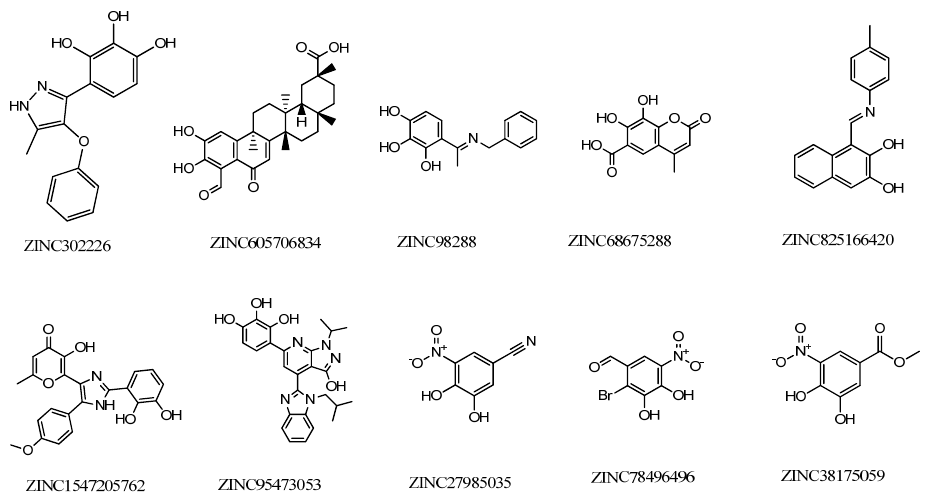
Figure 13. Structure and identification of the studied compounds. Table 3. Estimated IC 50 values (nM) for selected compounds with MBCOMT performed in this work in comparison with previous ones reported in the literature. Values are means with 95% confidence ( n = 2 to